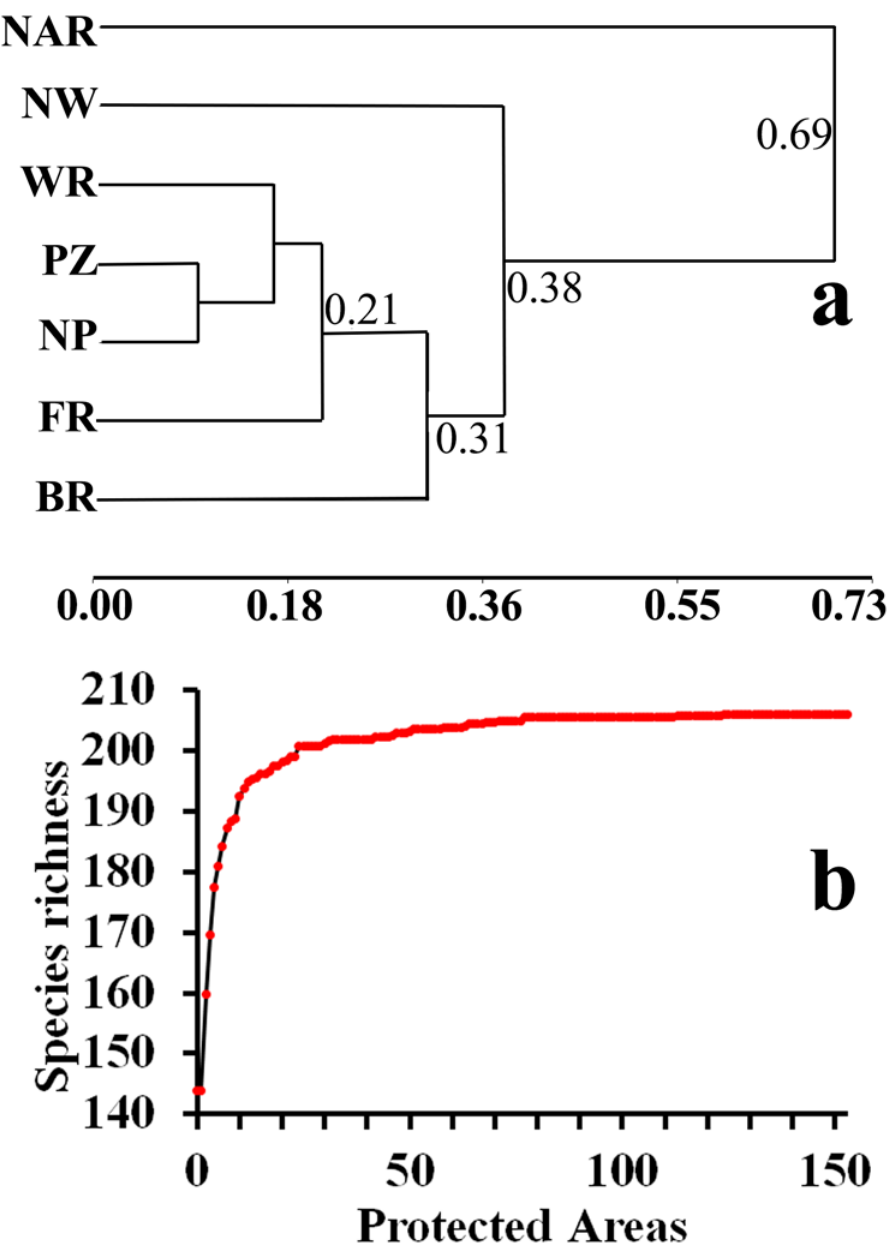
Fig 4. Complementarity of protected areas for representing mammal species richness in Costa Rica. a) Cluster analyses of species diversity using the Jaccard index between protected area categories (National parks (NP), Wildlife Refuges (WR), Forest Reserves (FR), Protected Zones (PZ), National Wetlands (NW) and Biological Reserves (BR)) and b) cumulative number of species protected.